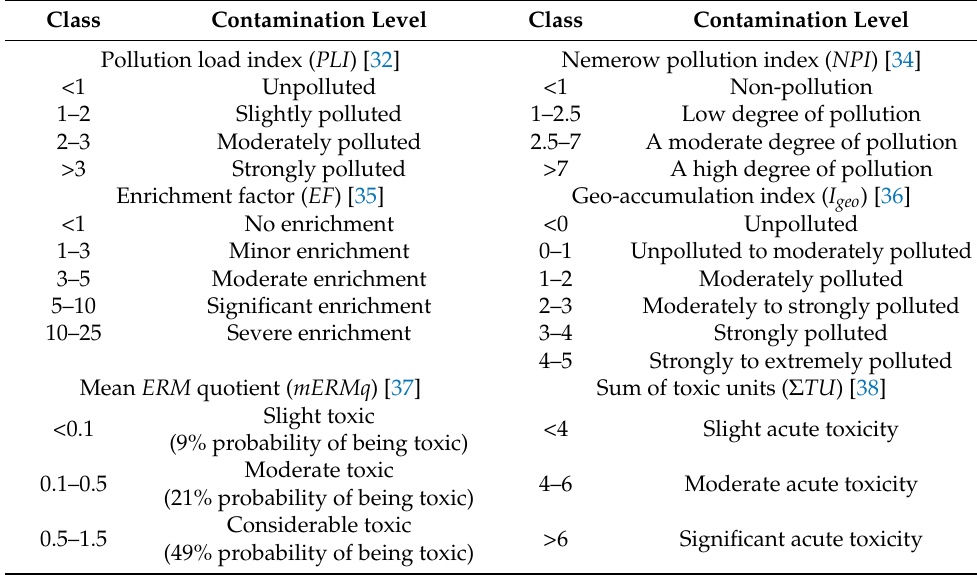
Table 1. Classification of sediment contamination levels based on sediment pollution